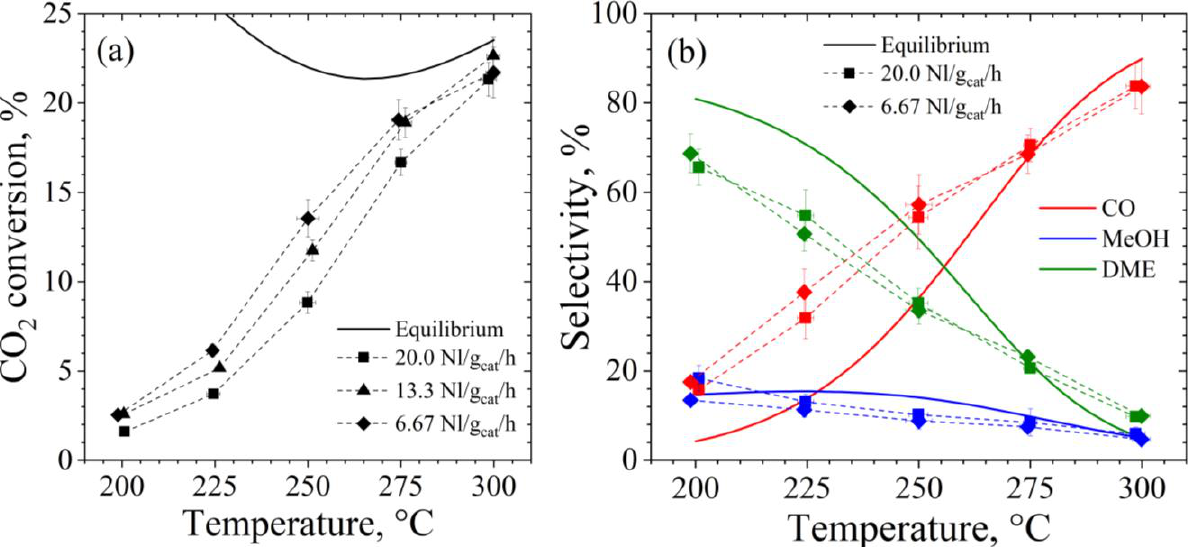
Figure 6. ( a ) CO 2 conversion and ( b ) CO, CH 3 OH and DME selectivity of CZZ/FER OX 2:1.